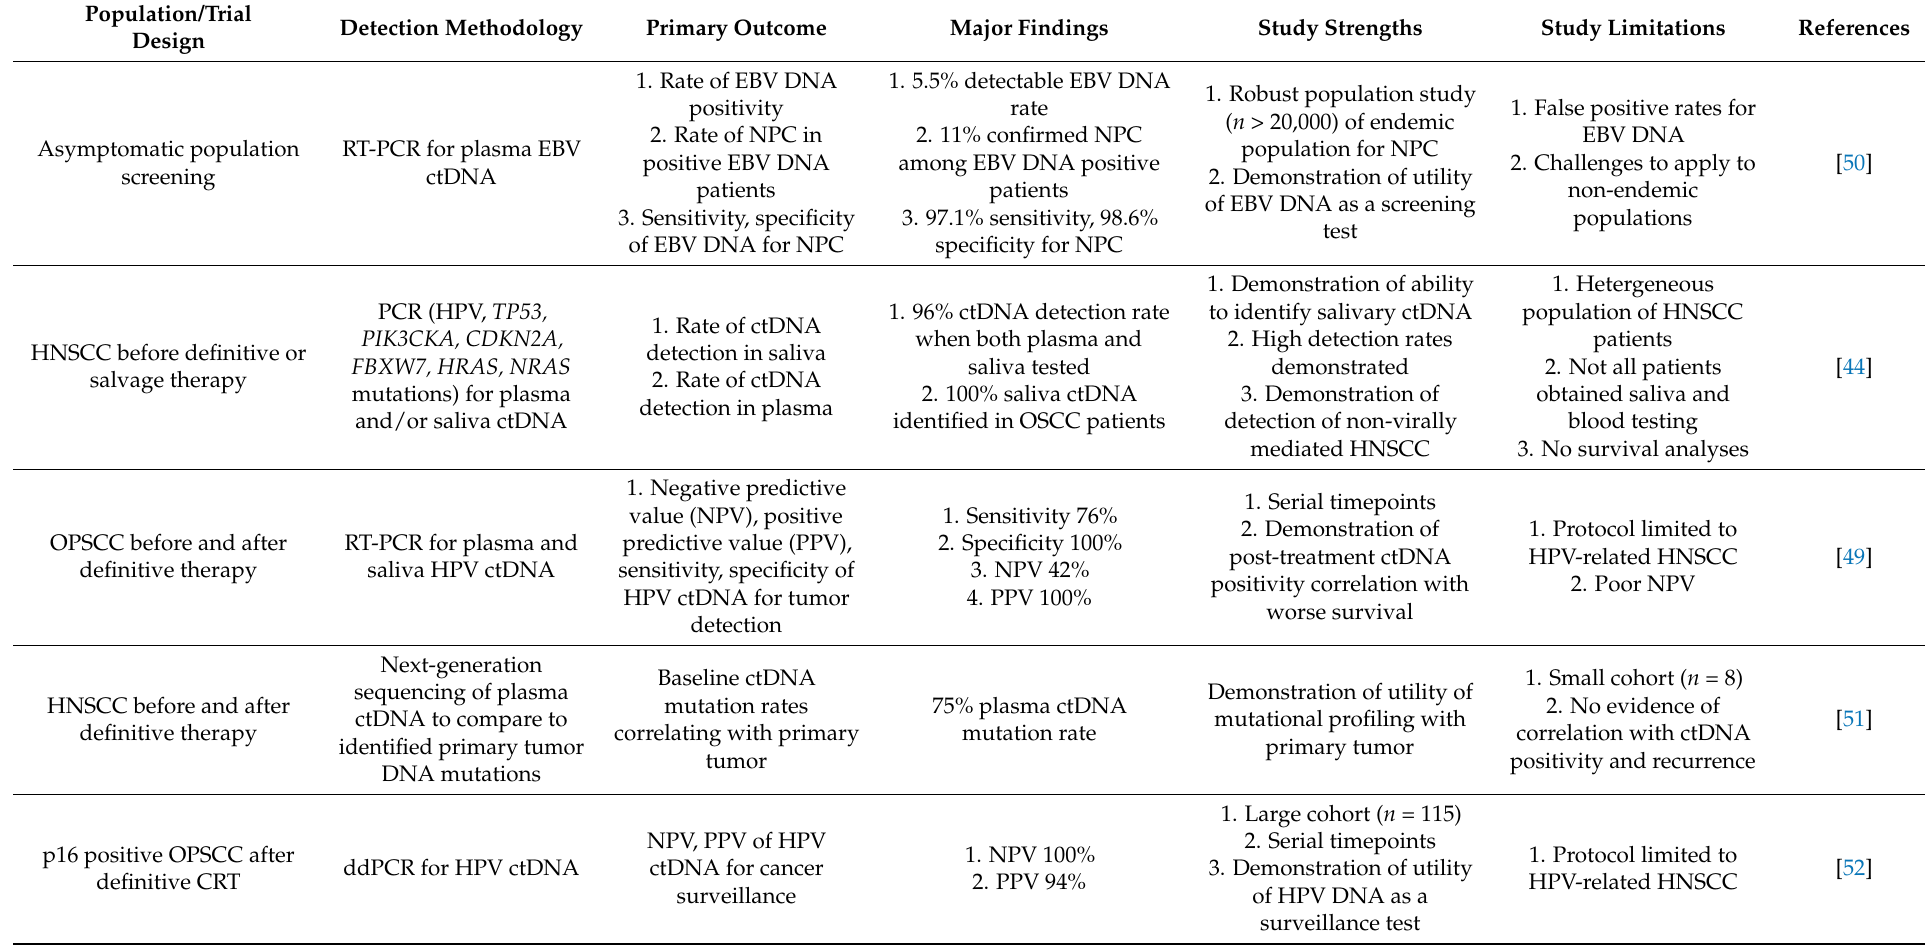
Table 2. Key studies investigating circulating tumor DNA (ctDNA) as biomarkers in